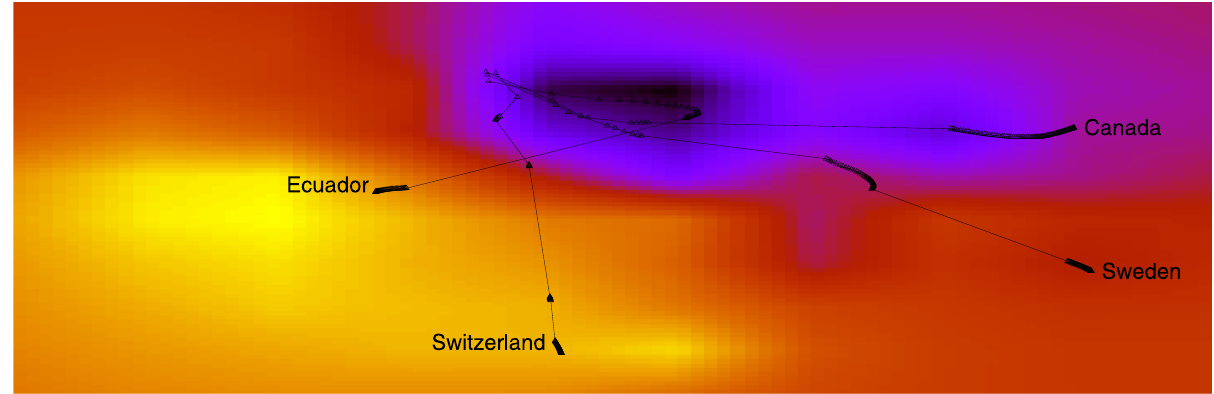
Fig 5. (Color online) heatmaps showing the trajectories for Ecuador, Switzerland, Sweeden, and Canada.